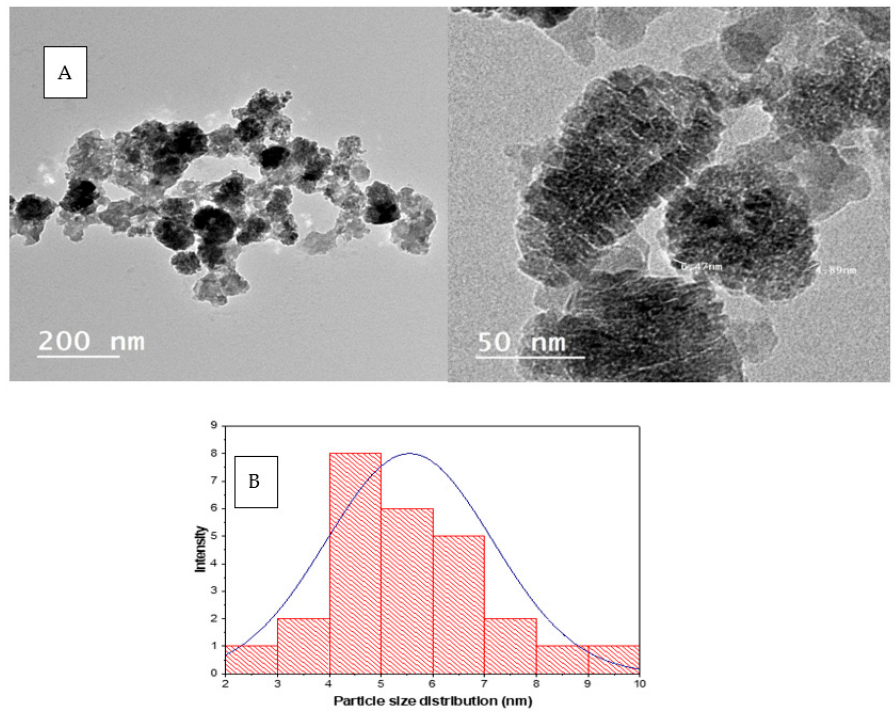
Figure 2. ( A ) TEM images of ZnO nanoparticles synthesized using P. zonale leaves extract (Pz-ZnO- NPs) and ( B ) particle size distribution histogram.